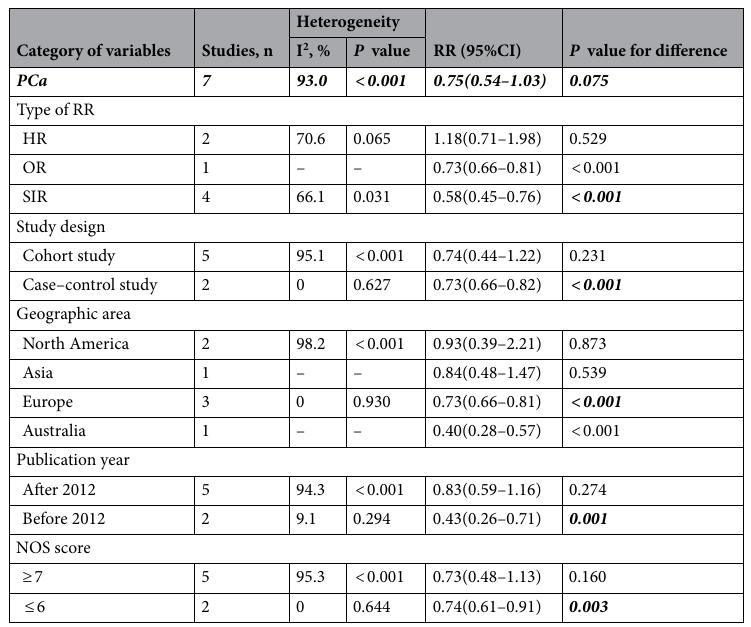
Table 3. Subgroup analysis of association between PCa risk. HCV = hepatitis C; RCC = renal cell carcinoma; BC = bladder cancer; PCa = prostate cancer; RR = relative risk; HR = hazard ratio; OR = odds ratio; SIR = standardized incidence ratio; NOS = Newcastle–Ottawa Scale;